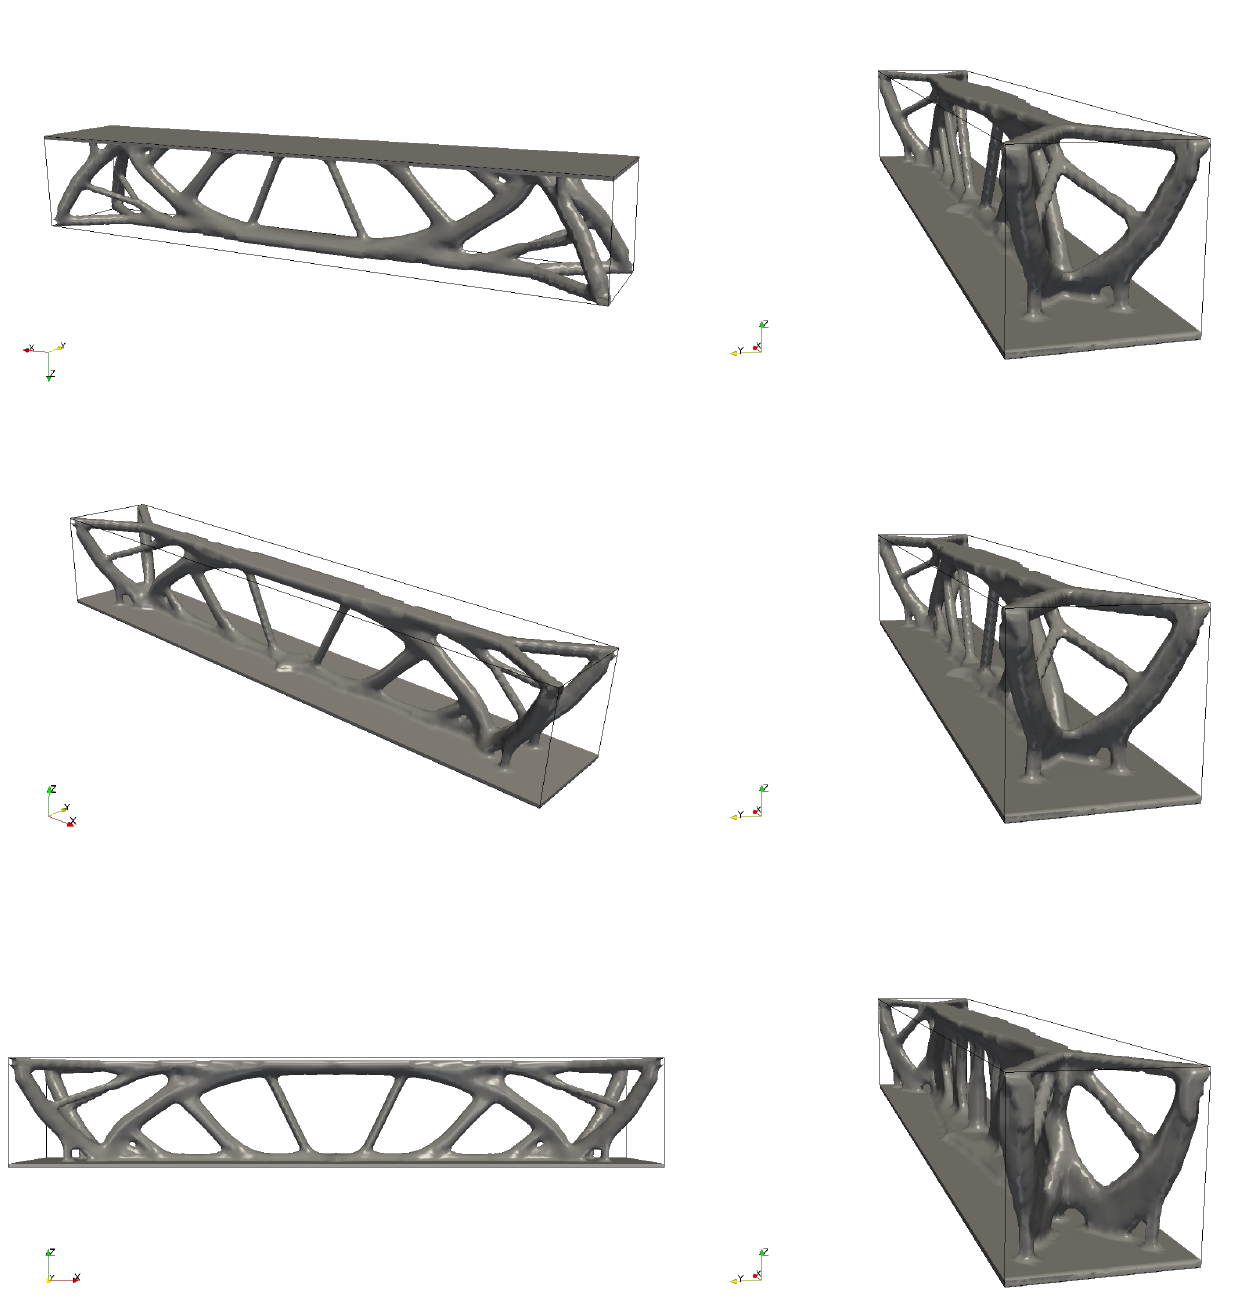
Fig. 11 (Left) Different views of the optimized shape for the three-dimensional bridge example of Section 5.5, solving Problem (30) with α c = 0 . 1 ; (right) another view on the three-dimensional bridges for Problem (30) with (top) no manufacturing constraint, (middle) α c = 0 . 7 and (bottom) α c = 0 . 1